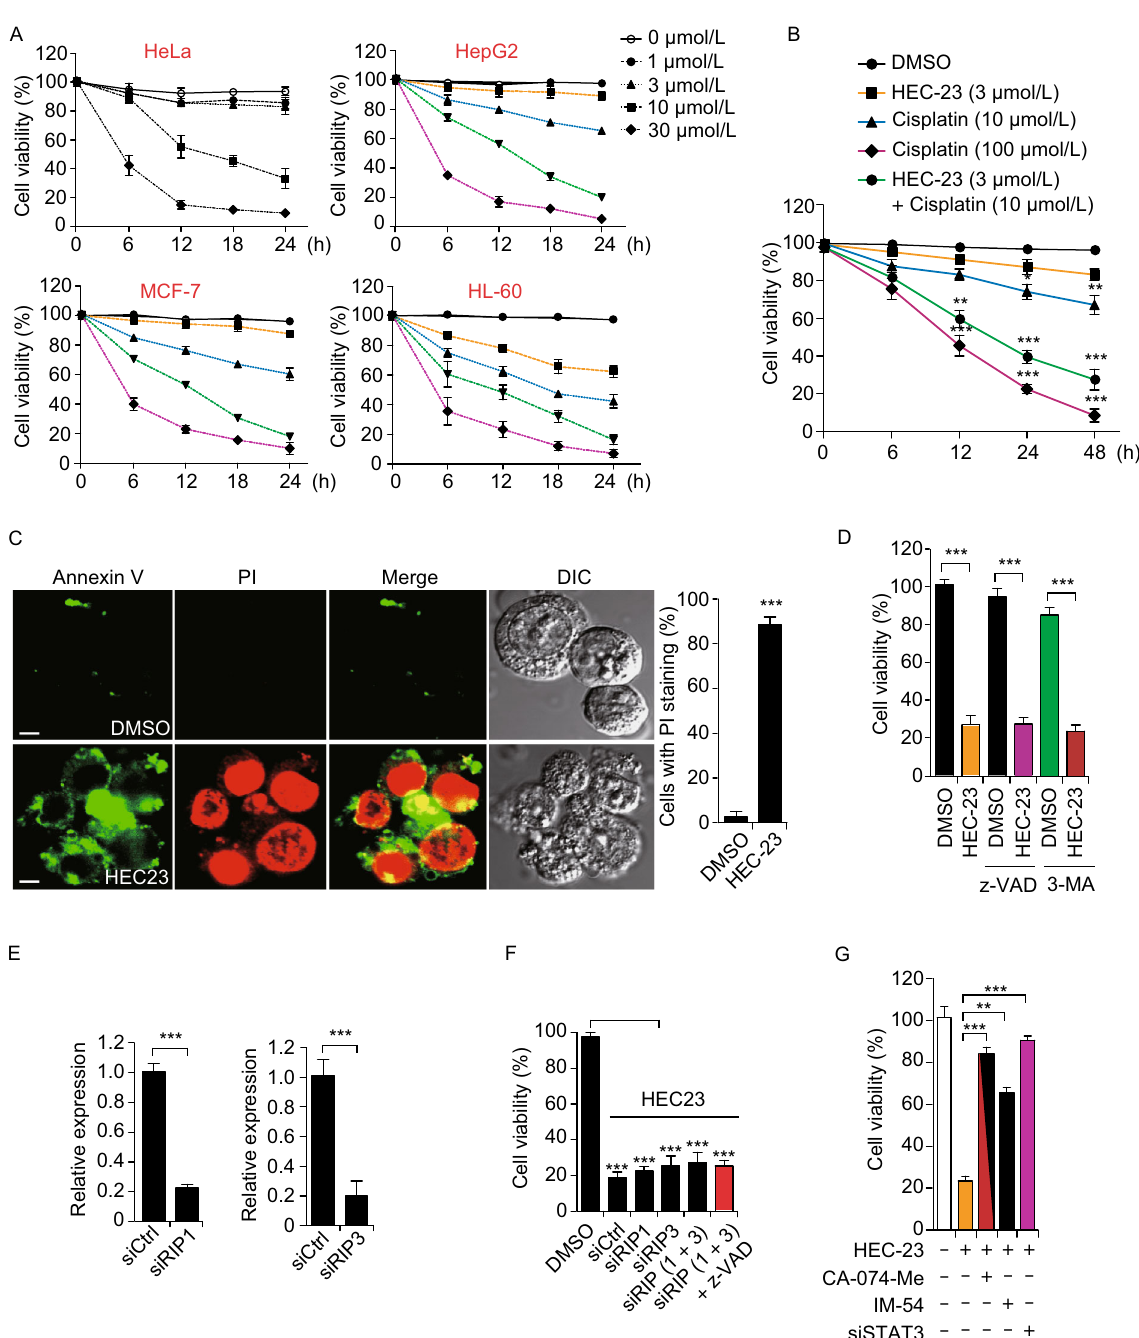
Figure 6. HEC23-induced cell death is dependent on the STAT3-cathepsin pathway. (A) Quanti fi cations of cell death induced by HEC-23 in the indicated types of carcinoma cells. (B) Quanti fi cation of cell death induced by HEC-23 together with or without cisplatin in HeLa cells. (C) Representative images (left) and fl ow cytometry quanti fi cation (right) of necrosis induced by HEC-23 (10 μ mol/L, 12 h). (D) Quanti fi cation of cell death induced by HEC-23 (10 μ mol/L, 24 h) in HeLa cells pre-treated with z-VAD (20 μ mol/L) or 3-MA (1 μ mol/L) for 30 min. (E) qPCR evaluation of the knockdown ef fi ciency of siRIP1 and siRIP3. (F) Quanti fi cation of the viability of HeLa cells treated with HEC-23 and siRIP1, siRIP3 or both in the presence or absence of z-VAD. (G) Quanti fi cation of cell viability in siCtrl or siSTAT3 HeLa cells treated with HEC-23, CA-074-Me or IM-54. HeLa cells were transfected with siRNA for 48 h, followed by treatment with CA-074-Me (20 μ mol/L) or IM-54 (2 μ mol/L) for 30 min. The cells were then treated with HEC-23 for 24 h.